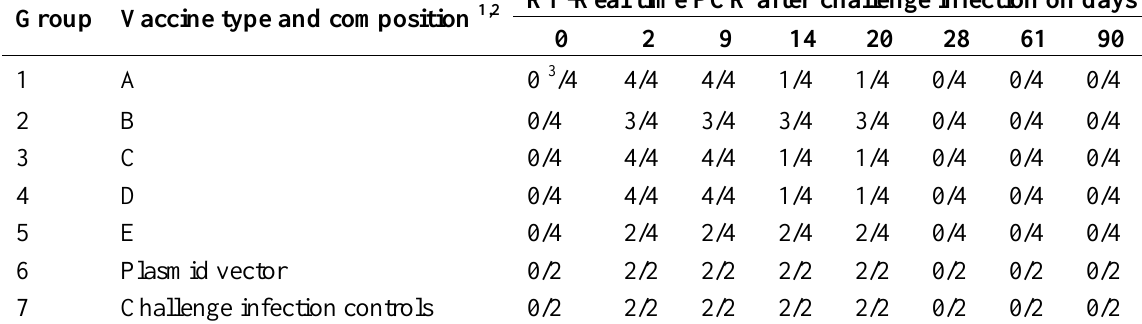
Table 3. Porcine reproductive and respiratory syndrome virus (PRRSV) detection in serum samples by RT-Real time PCR from pigs, immunised with experimental DNA vaccines, and challenge infected with virulent PRRSV.